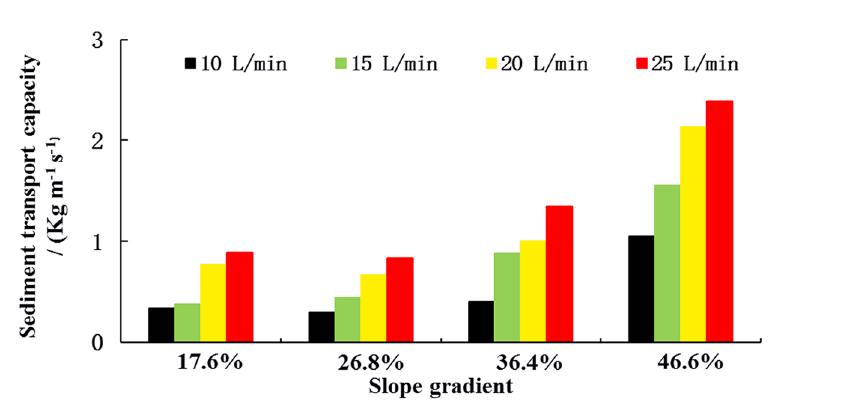
Figure 1. Sediment transport capacity of the concentrated flow under different slope gradients and flow rates.